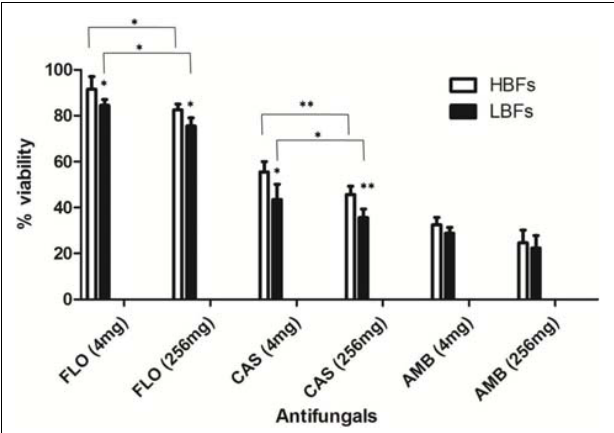
FIGURE 3 | Impact of Candida albicans biofilm formation on antifungal susceptibility. Ten low biofilm formers (LBFs) and high biofilm formers (HBFs) were standardized to 1 × 10 6 cells/mL in RPMI-1640, and grown as biofilms in flat-bottomed 96-well microtiter plates for 24 h. Biofilms were washed with phosphate-buffered saline before being treated with 4 mg/L or 256 mg/L fluconazole (FLO), caspofungin (CAS), and amphotericin B (AMB). Following treatment, the proportional viability was compared with that untreated control by use of an XTT metabolic assay. ∗ p < 0.05, ∗∗ p <